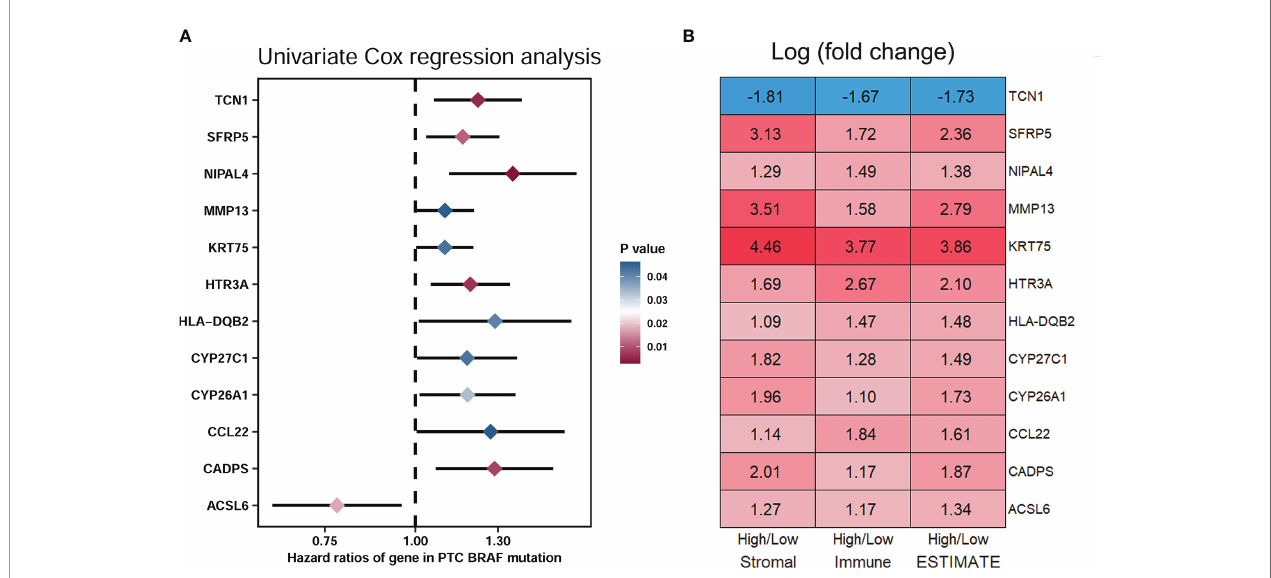
FIGURE 5 | Screening of DEGs related to signi fi cant prognosis in BRAF-mutated PTC. (A) The forest plot showed that 12 DEGs ( TCN1, SFRP5, NIPAL4, MMP13, KRT75, HTR3A, HLA-DQB2, CYP27C1, CYP26A1, CCL22, CADPS and ACSL6 ) were signi fi cantly associated with the PFS of PTC patients with BRAF mutation (p < 0.05) by univariate Cox regression analysis. (B) Module diagram showing the log2 fold changes (FCs) in the twelve selected DEGs between the high vs. low stromal/ immune/ESTIMATE score groups.